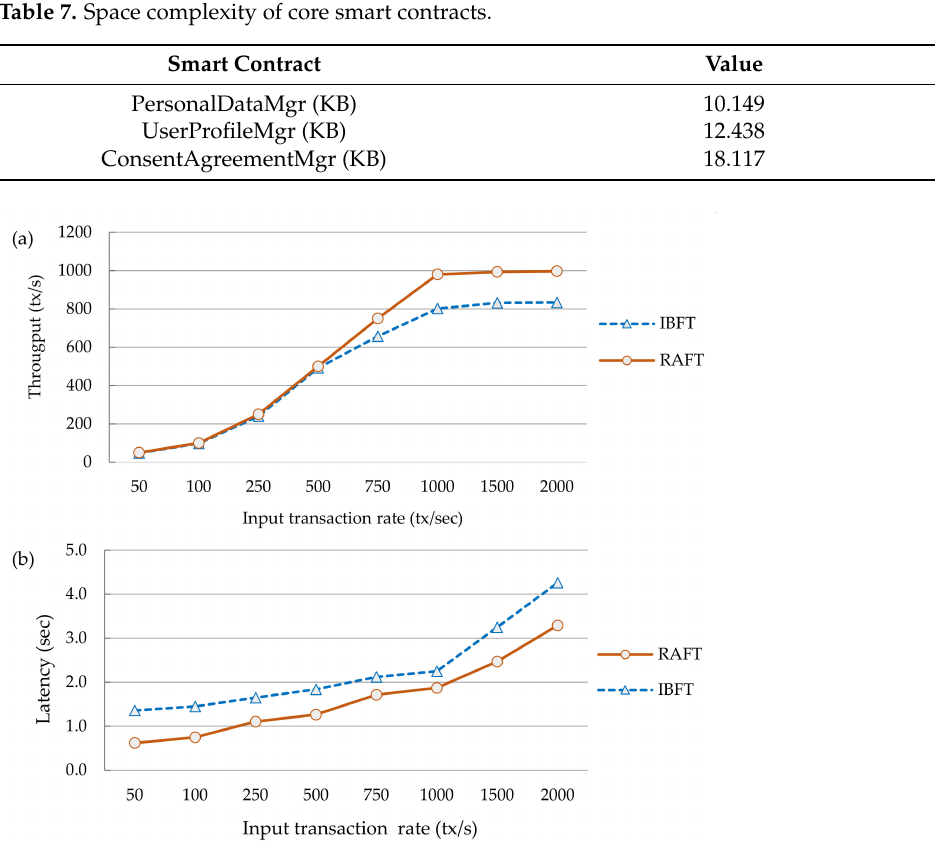
Figure 7. ( a ) Transaction throughput evaluation of IBFT vs. RAFT and ( b ) transaction latency evaluation of IBFT vs. RAFT.